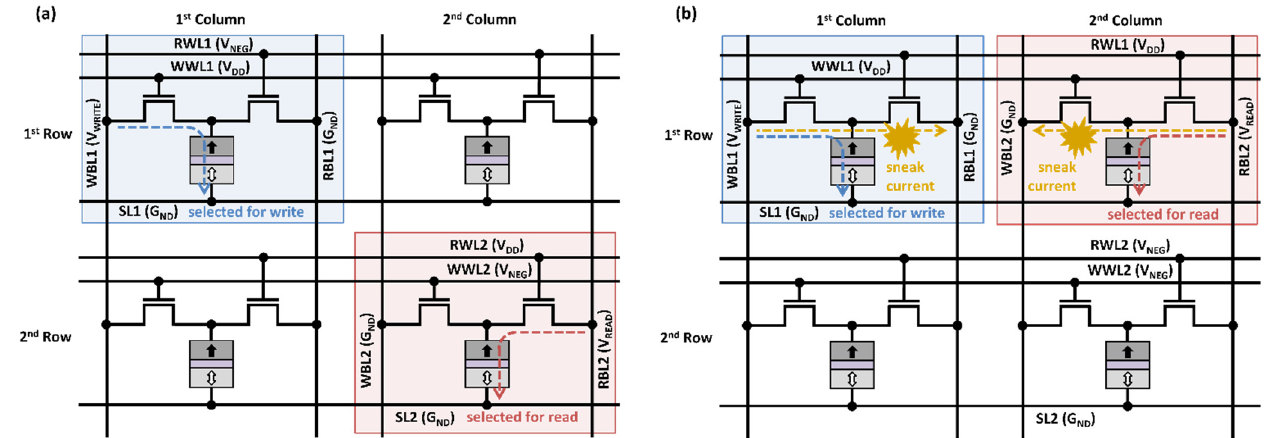
Figure 4. ( a ) Simultaneous write and read accesses in a 2 × 2 array of 1R/1W STT-MRAM in distance- 2 bit-interleaving architecture; ( b ) a simultaneous access conflict occurred when accessing different words in a same row.